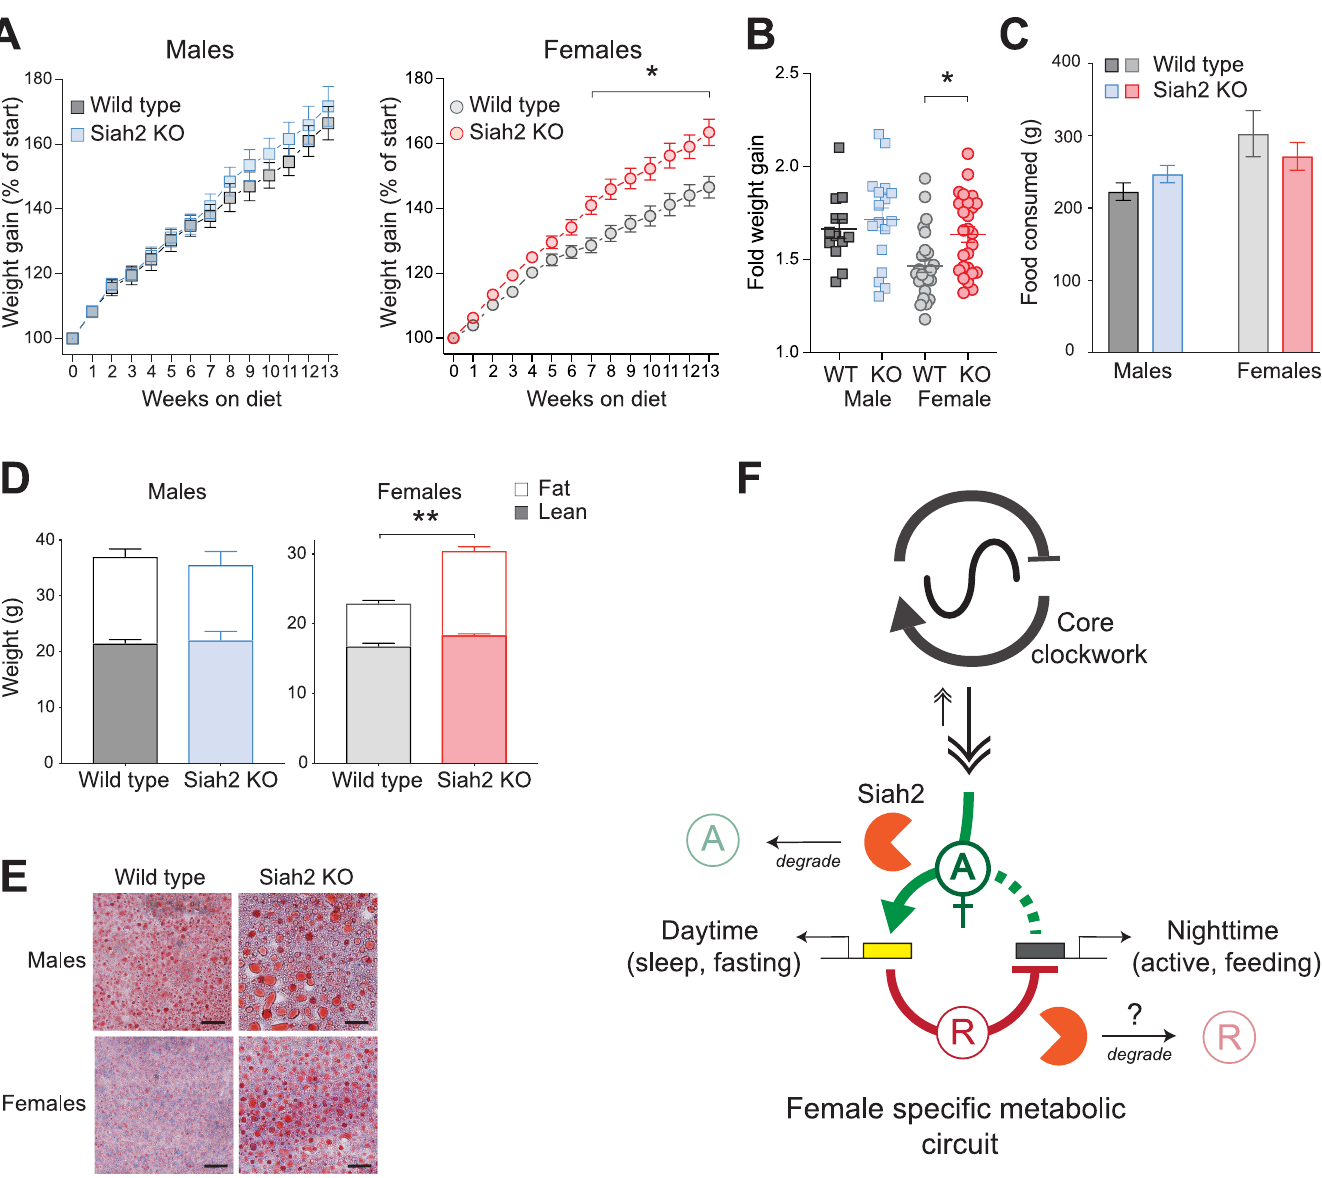
despite differences in experimental designs (single timepoint vs. around the clock). We found that SIAH2-deficiency does alter rhythmic gene expression in males, but the changes were dis- tinct in every way from those in females. In females, the effects of SIAH2-deficiency were time-of-day specifc and focused predominantly on transcription factors and genes involved in regulating lipid and lipoprotein metabolism. The metabolic genes affected in females operate